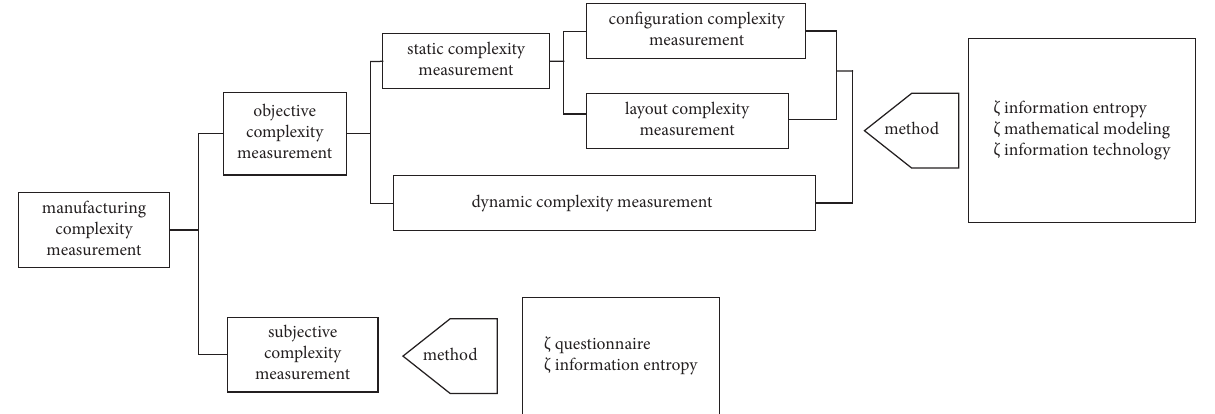
Figure 1: Content and methods of complexity measurement of the manufacturing